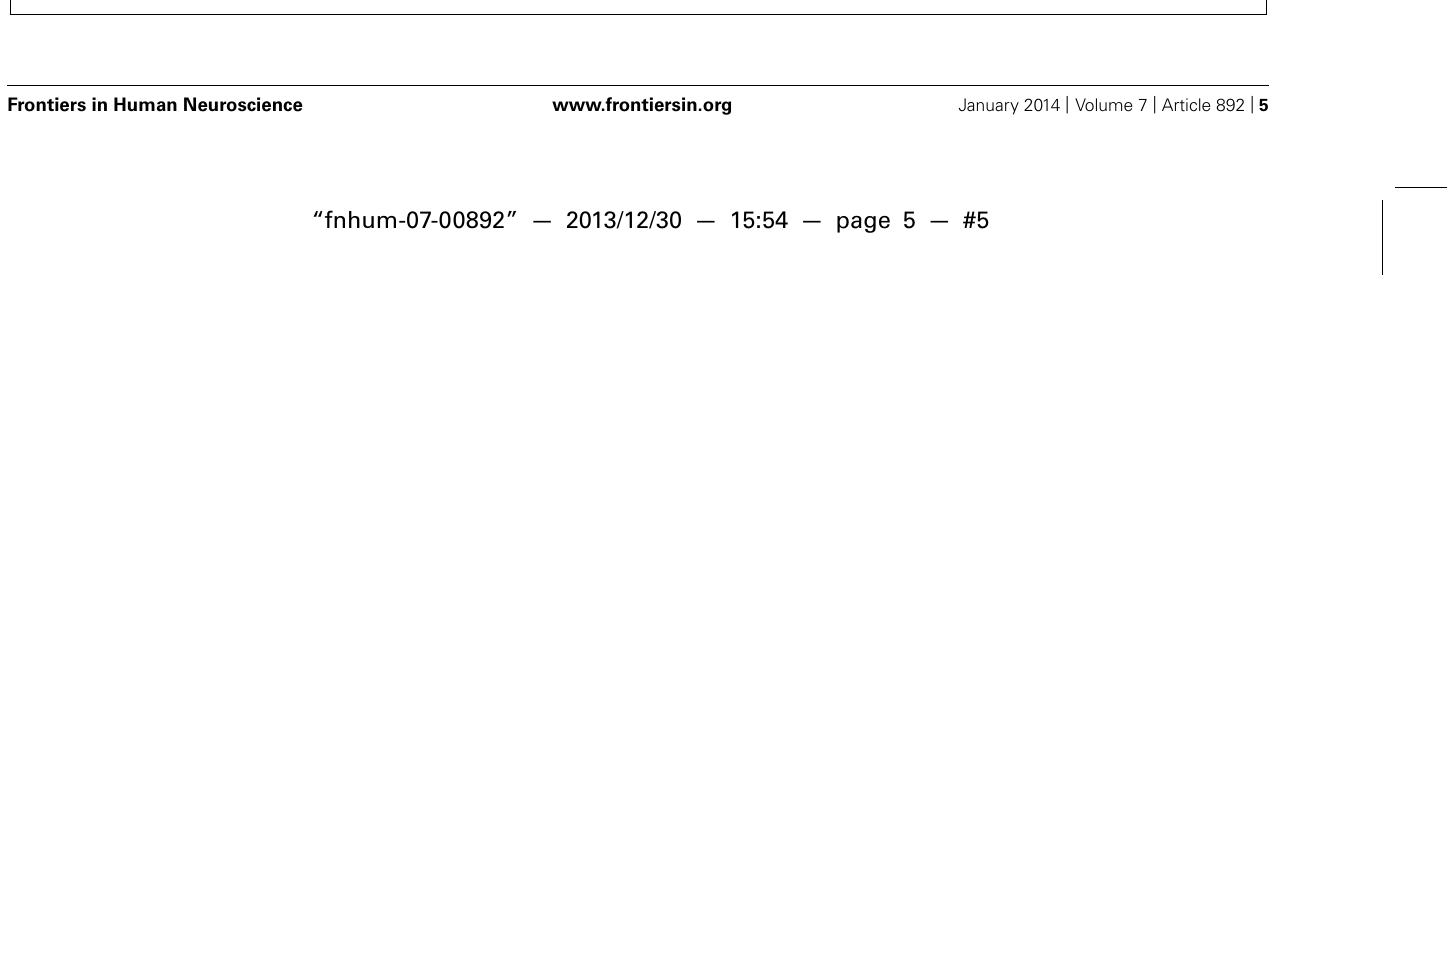
FIGURE 2 | Performance duringTraining trials: left – average number of moves used to reach target location within each trial; right – average number of individual changes in camera direction within each trial. Error bars represent standard error, trial numbers on the x -axis match those listed in Table 1 .